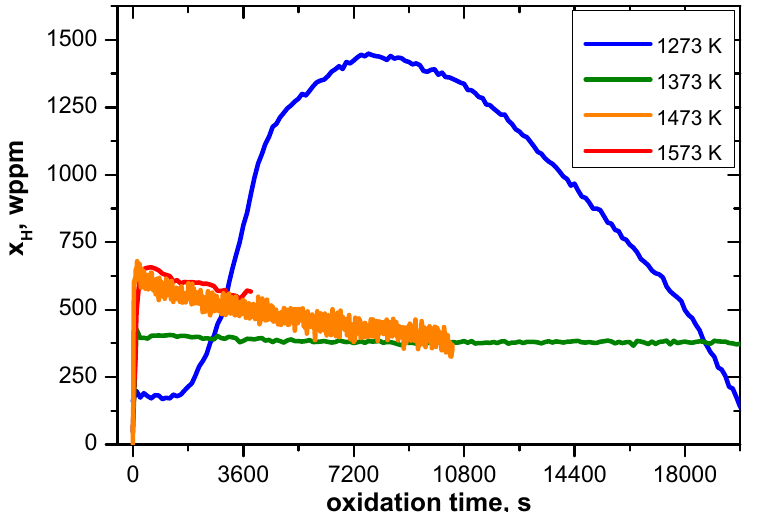
Figure 10. Development of the hydrogen concentration during isothermal oxidation of Zry-4 in steam at temperatures of 1000, 1100, 1200, and 1300 °C.